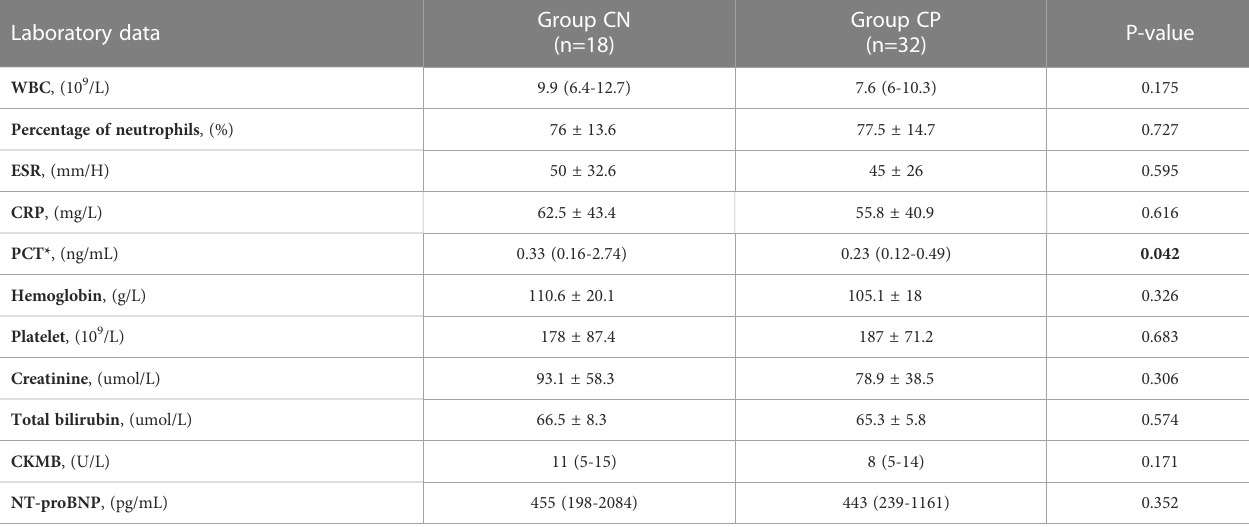
TABLE 2 Compared of laboratory examinations in culture-negative IE and culture-positive IE patients.